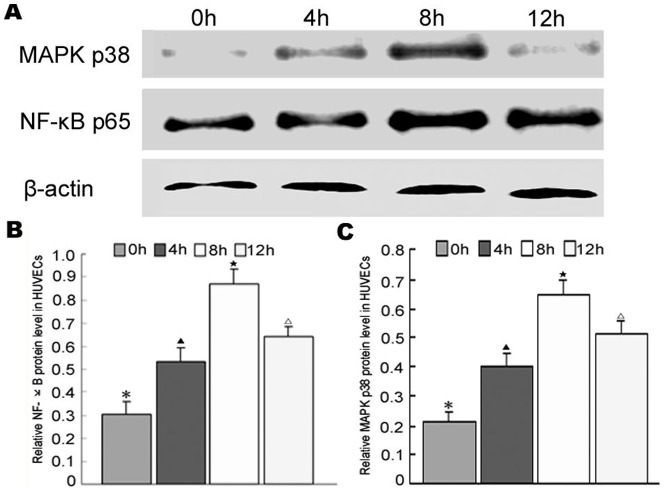
AngII treatment was shown to increase NF-κB p65 and MAPK p38 expression in HUVECs by western blotting.(A) MAPK p38 and NF-κB p65 expression levels detected by western blotting. (B) Semi-quantitative analysis of the NF-κB levels detected by western blotting. (C) Semi-quantitative analysis of the MAPK p38 levels detected by western blotting. Different symbols indicate statistical significance (p<0.05).